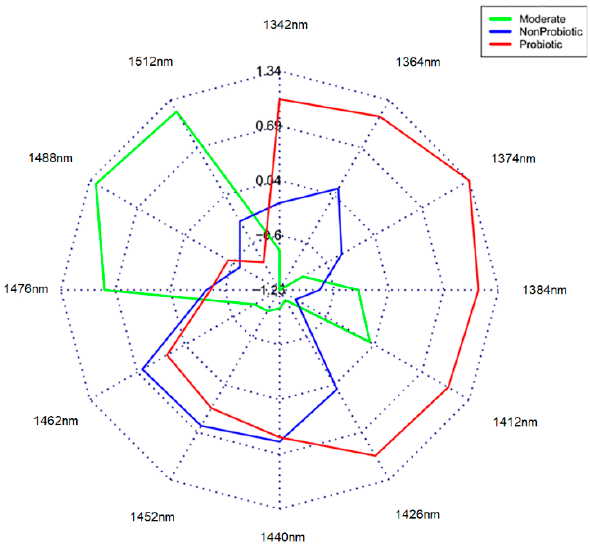
Figure 8. Aquagrams of culture media of groups of probiotic, moderate and non-probiotic strains. Average values of normalized absorbance values of the water matrix coordinates for each group are plotted on each wavelength axis. Figure adapted from original.